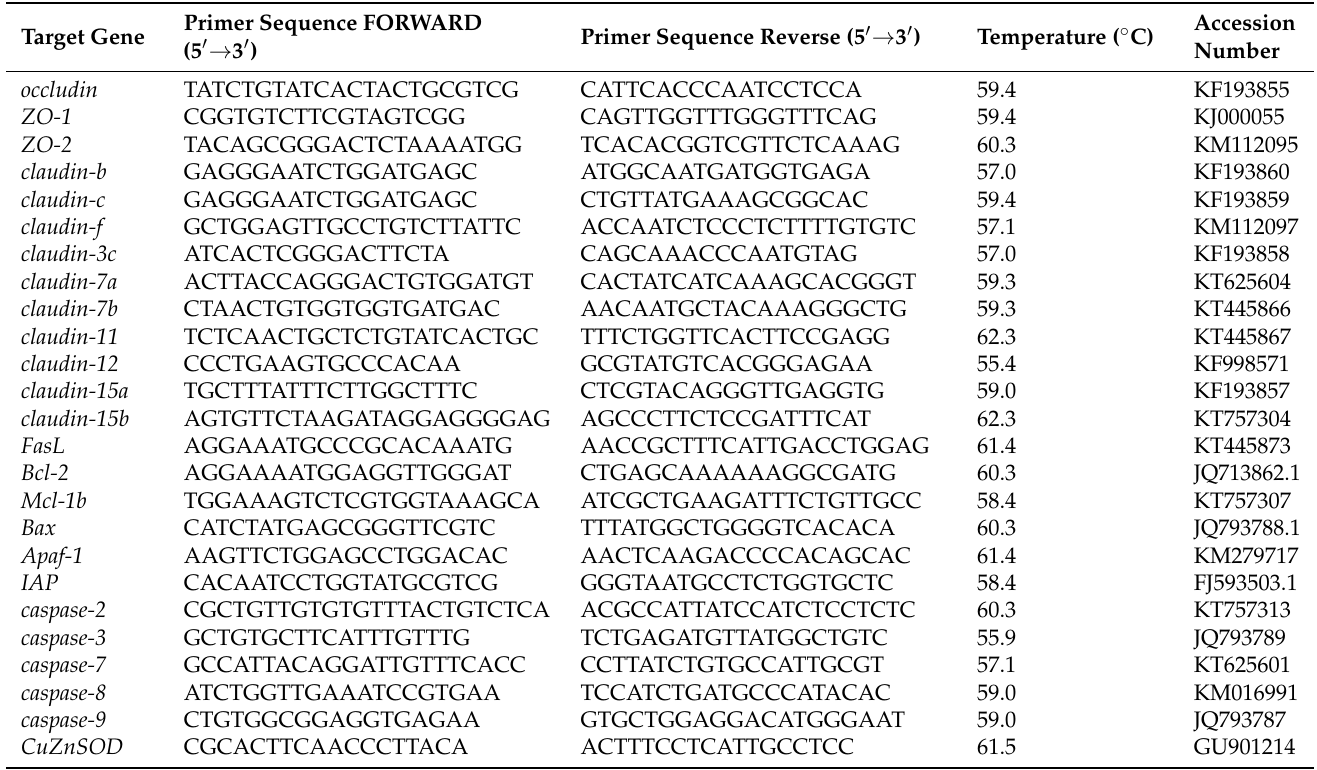
Table 2. Real-time PCR primer